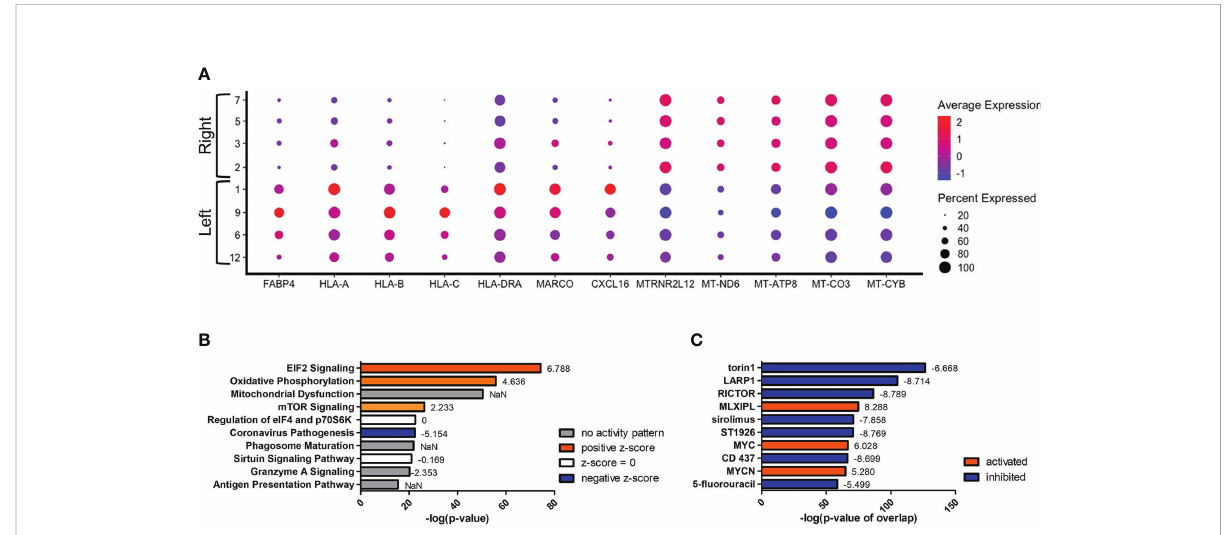
FIGURE 5 Upregulation of Antifungal Genes in Left Side Clusters #1/9/6/12. Processed human BAL cells were enriched for phagocytic APCs and incubated with C neoformans strain H99 for 2h and processed for scRNA-seq. Genes differentially expressed in clusters #1/9/6/12 when compared to clusters #2/7/5/3 were analyzed by IPA. (A) Differential expression of select genes in clusters #1/9/6/12 (left) and #2/7/5/3 (right). Top 10 signi fi cantly regulated canonical pathways (B) and predicted upstream regulators (C) as ordered by p -value or p -value of overlap. To the right of each bar is the statistical z-score for each pathway or upstream regulator with positive and negative being increased and decreased, respectively (NaN = not a number, no activity pattern). Data shown are combined analysis of cells from three individual experiments (n=3).